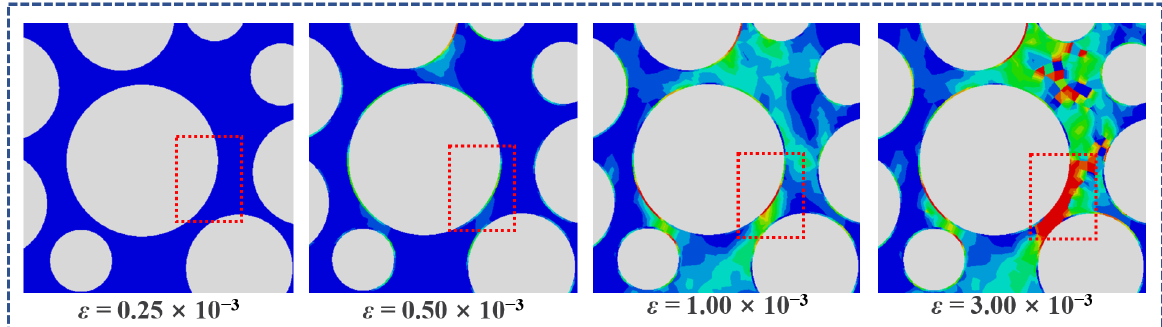
Figure 27. Mesoscale damage evolution of ITZ in the case of splitting tensile.